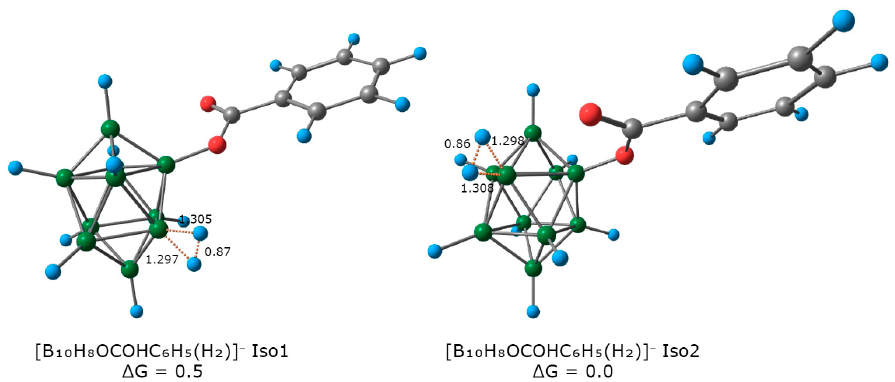
Figure 6. The structure of main isomers of [B 10 H 8 OC(O)C 6 H 5 (H 2 )] − anion. Length units—Å, energy units—kJ/mol, ω B97X-D3/def2-TZVPP level of theory.